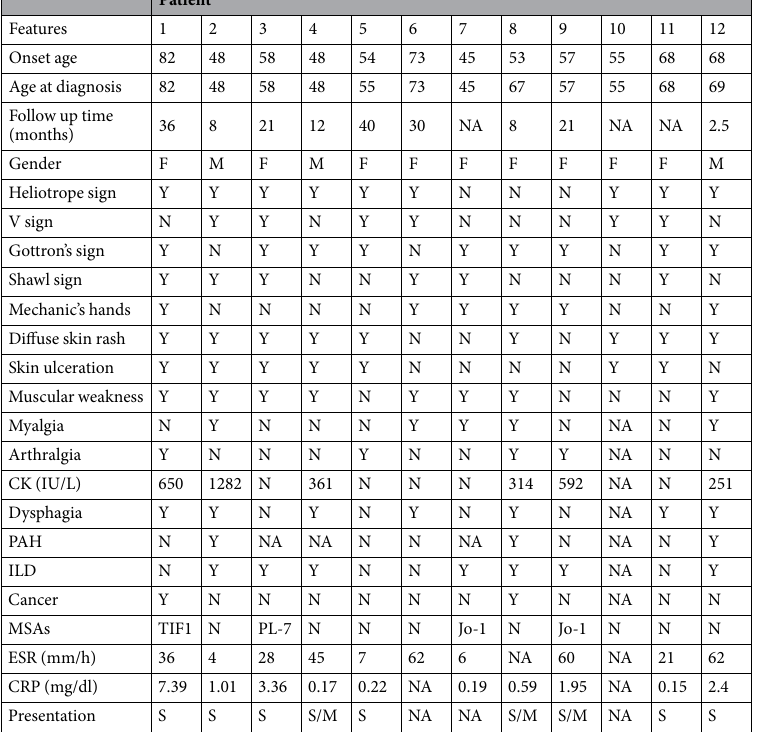
Results The frequency of anti-SAE antibodies in Chinese patients with PM/DM. In total, 14 patients were discovered by enzyme-linked immuno sorbent assay (ELISA) to be carrying anti-SAE1 antibodies, and 12 of these cases were confirmed by protein immunoprecipitation (IPP). The overall frequency of anti-SAE antibody occur- rence in the PM/DM cohort was 2.1%. Anti-SAE antibodies were found exclusively in patients with adult-onset DM (n = 394), with a frequency of 3.0%. Among the 144 PM patients, none carried anti-SAE antibodies, and none of the 32 JDM patients carried the antibody. Anti-SAE antibodies were not present in the healthy controls or in the disease control groups, i.e. patients suffering from idiopathic hyper-creatine kinase-emia, systemic sclerosis (SSc), muscular dystrophy, myasthenia gravis, motor neuron disease, or mitochondrial myopathy. Characteristics of anti-SAE antibody-positive Chinese DM patients. There were 9 (75%) females and 3 (25%) males among the 12 patients carrying the anti-SAE antibody (Table 1). The clinical features of the patients are listed in Table 1. The average age of DM onset among the anti-SAE antibody-positive patients was 59.1 years. Of these patients, 9/12 (75%) presented with the hallmark cutaneous manifestations of DM (heliotrope sign rash and Gottron’s sign rash), and 6/12 (50%) showed shawl sign rash and V sign rash. In addition to these classic skin rashes, another characteristic skin lesion is a diffuse dark-red skin rash or diffuse pigment-like skin rash observed in 75% (9/12) of patients carrying the anti-SAE antibody. Rash ulceration appeared in 7/12 (58%) patients. Six patients carrying anti-SAE antibodies exhibited cutaneous DM only (without muscular weakness), but then gradually developed typical myositis. The median time interval from initial skin rash to myositis onset was 3.5 months. According to available data on these patients (complete data for one patient was unavailable), 8/12 (67%) patients exhibited muscular weakness; 6/12 (50%) experienced mechanic’s hands; 5/11 (45%) patients suffered myalgia; and 4/11 (36%) suffered arthralgia. Seven out of eleven patients (64%) were diagnosed with interstitial lung disease (ILD) via lung imaging exam- ination, but only one had respiratory symptoms. Seven (64%) patients experienced dysphagia; five patients expe- rienced difficulty in digesting solid food; four patients coughed when drinking water; and three patients had difficulty speaking coherently. Nasogastric tubes were applied in two of the cases. Three out of eight (38%) patients experienced the complication of mild pulmonary arterial hypertension (PAH). Cancers were observed in two patients. Eight out of 12 (67%) patients were ANA-positive. Five patients tested positive for other MAAs, including anti-RO-52, anti-ribonucleoproteins (RNPs), and the anticardiolipin